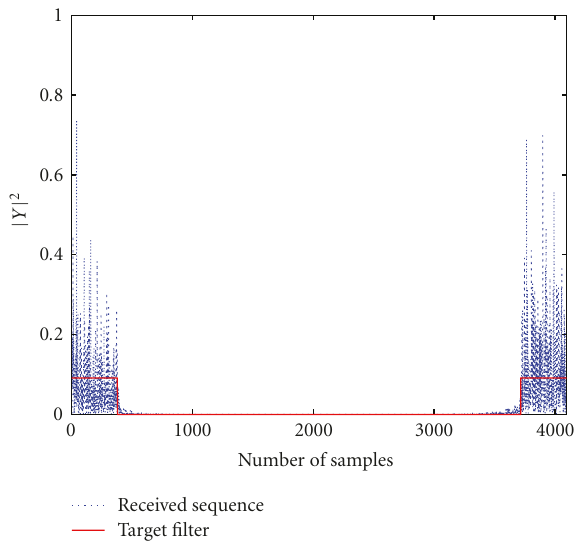
Figure 1: Estimation of the oversampling factor and power spectral density using real world measurement data.